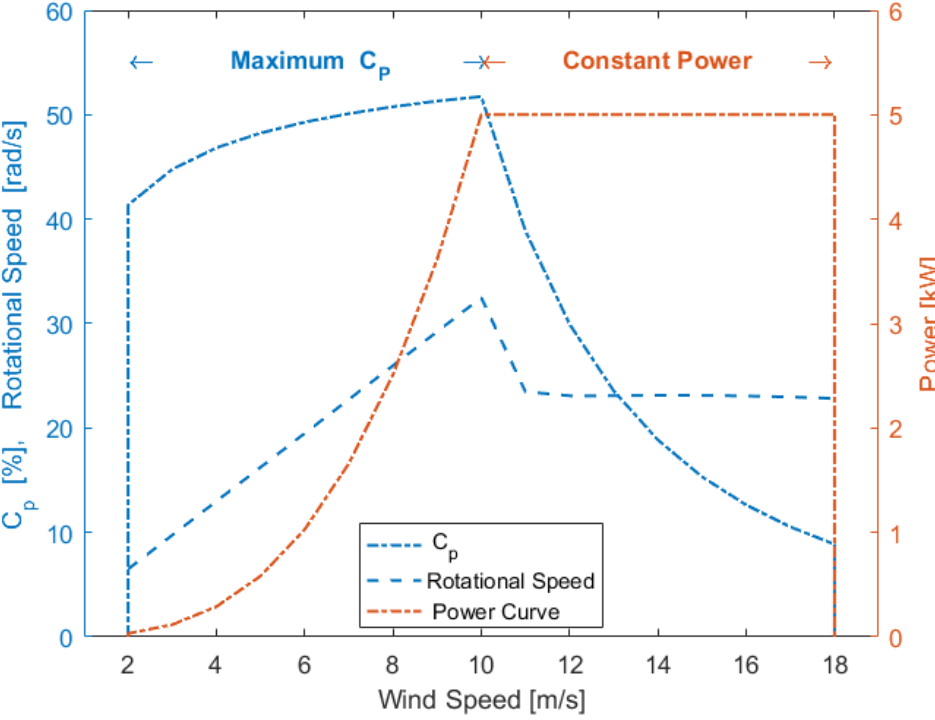
Figure 8. Power coefficient, power, and rotational speed, vs. wind speed of the designed blade for Figure 8. Power coe ffi cient, power, and rotational speed, vs. wind speed of the designed blade for the the operating range. operating